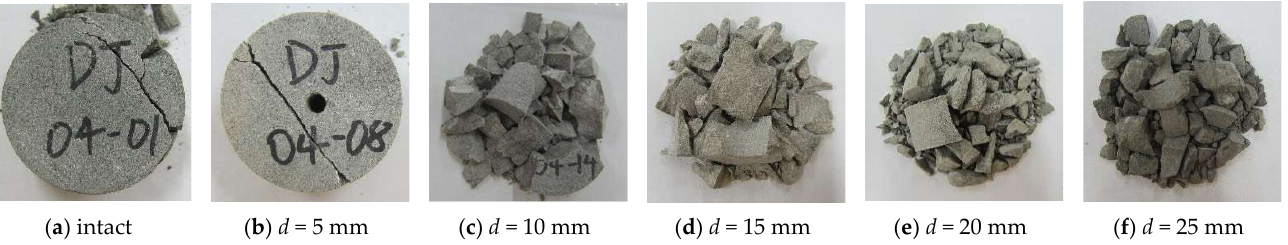
Figure 13. SEM test photos of sandstone specimens.